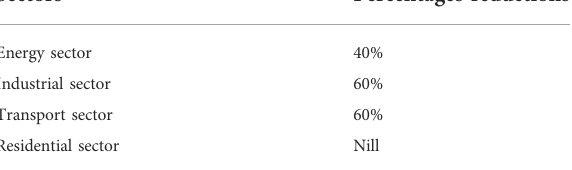
TABLE 1 Sector wise percent reduction in anthropogenic emissions over Arabian Peninsula during DLD.